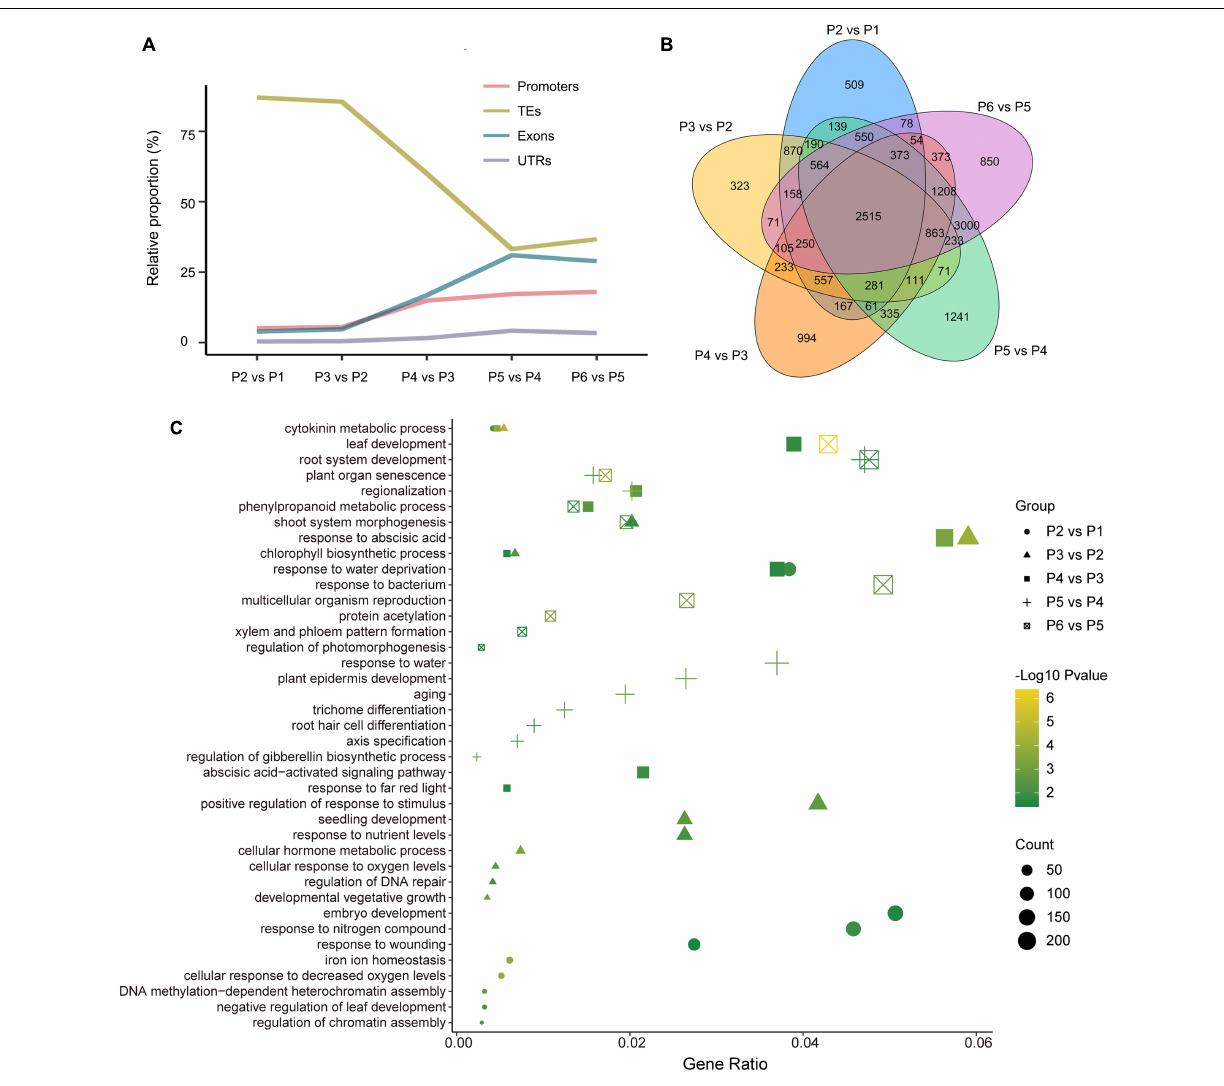
shoot system morphogenesis (GO:0010016) were enriched in P1–P3, while regionalization (GO:0003002), phenylpropanoid metabolic processes (GO:0009698), leaf and root development (GO:0048366, GO:0022622), as well as multicellular organism reproduction (GO:0032504) were enriched in the